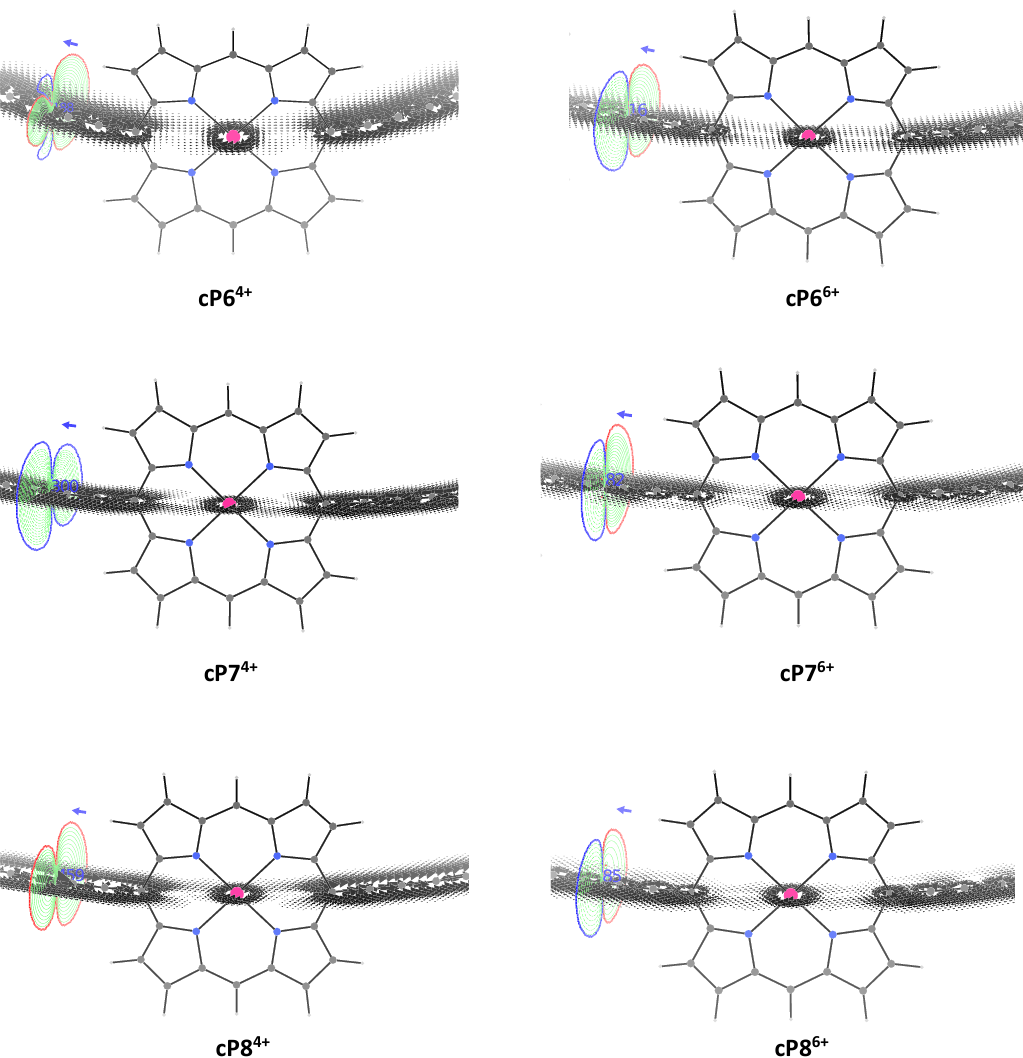
Figure 3. Integration domains for the current strengths reported in Tables 1 and 2. The current in the average molecular plane is also shown. A reference arrow with the size and direction of the maximum value of the delocalized benzene current is shown in blue. The magnetic field is oriented upwards and the center of the nanoring is behind the paper, so that arrows directed towards the right denote a paratropic current and arrows directed towards the left denote a diatropic